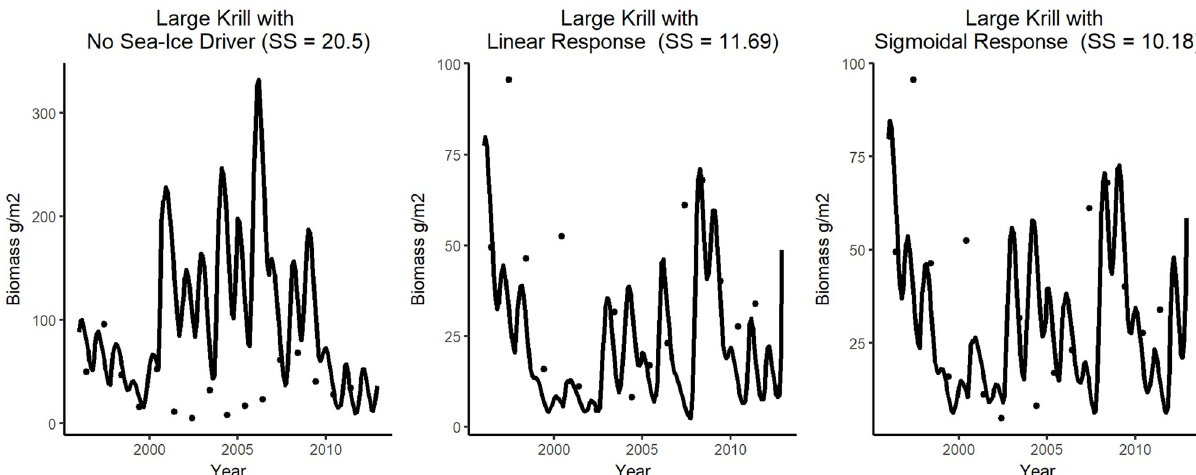
Fig 7. Evaluation of response curves for krill. Comparison of model fits (by group-specific SS) for krill when no curve was applied (a), the linear functional response curve was applied (b), and the sigmoidal functional response curve was applied(c). Curves are displayed in Fig 3 In all panels the dots represent the observed data and the lines represent model results. Note that the y-scale in panel a is significantly larger than the other two panels.